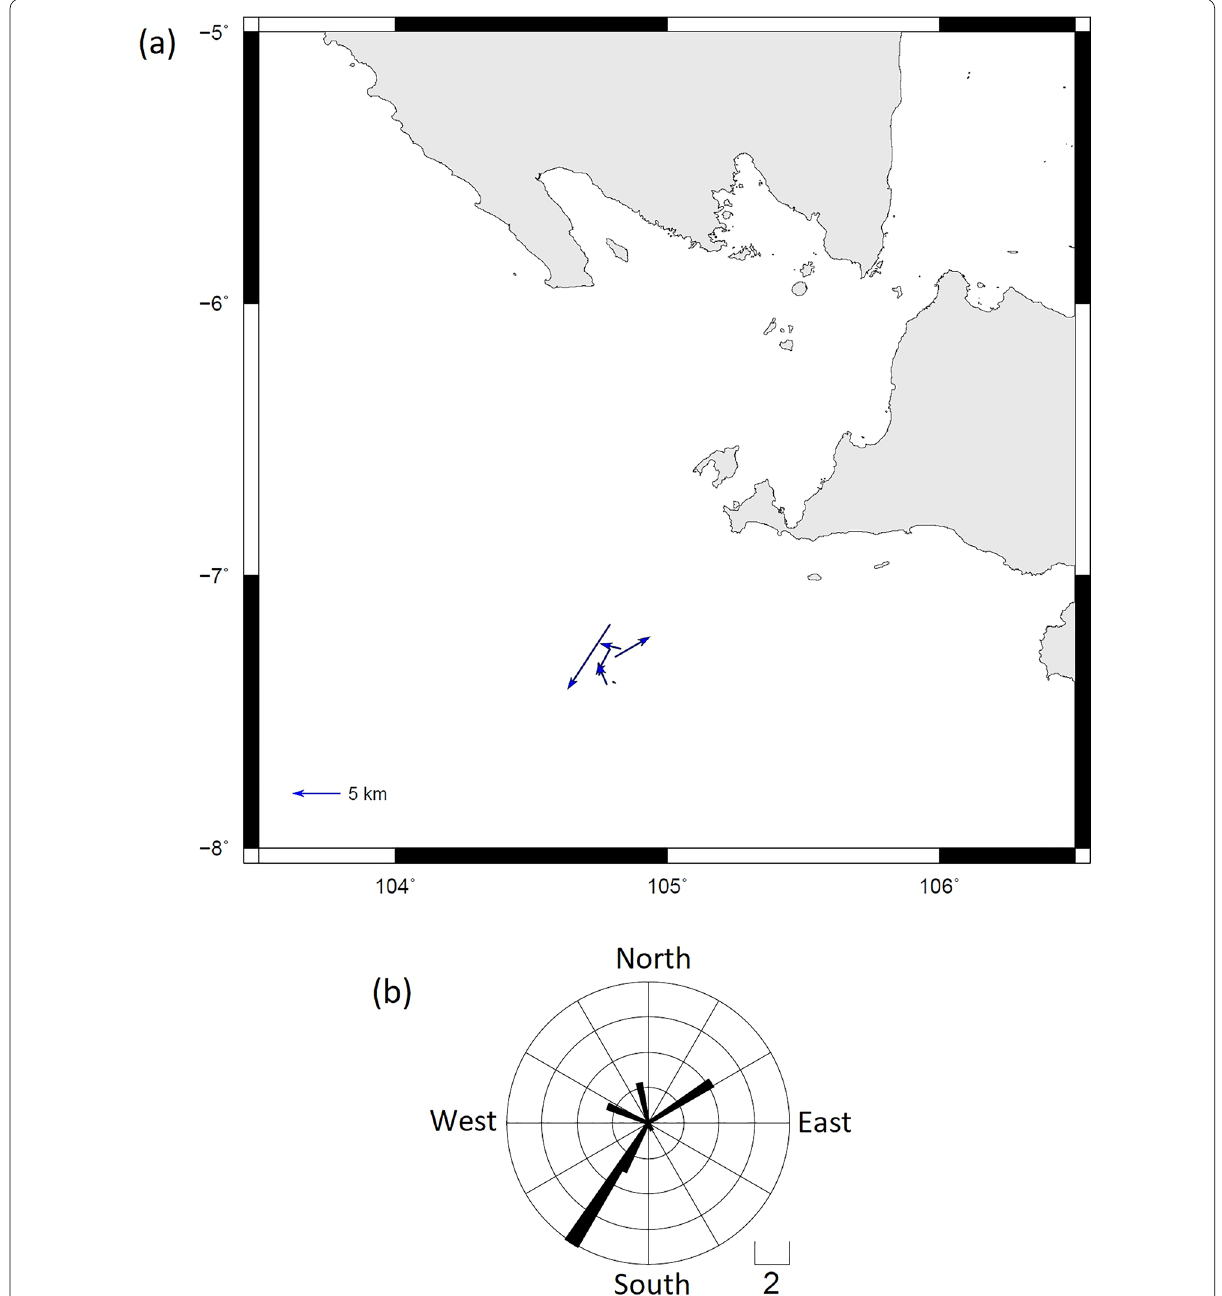
Fig. 8 a Epicenter shifts of the DD locations relative to the BMKG catalog; b Rose diagram showing the dominant direction of relocation